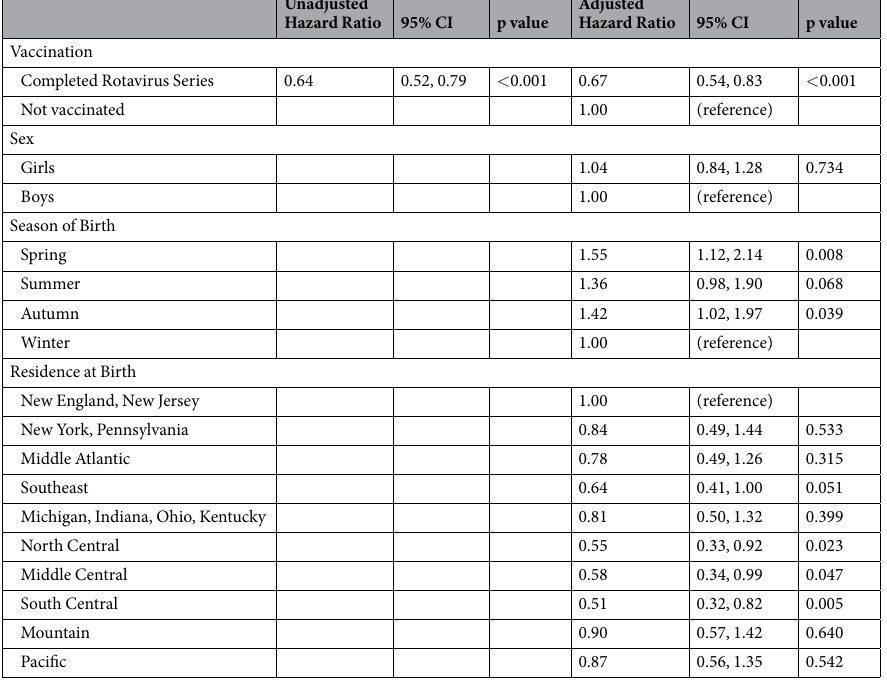
Table 3. Hazard Ratio for the Association between Rotavirus Vaccination and Type 1 Diabetes, 2006–2017.